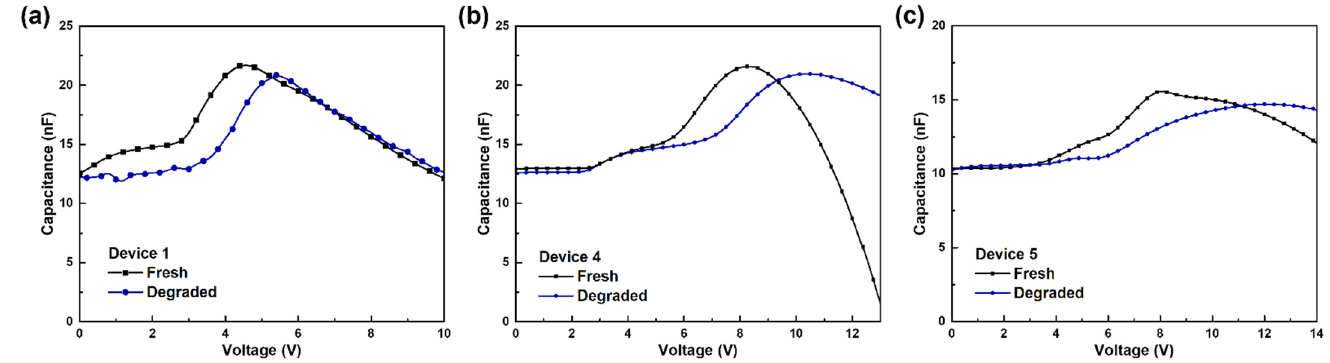
Figure 5. C-V characteristics of blue TADF OLEDs before and after degradation: ( a ) Device 1, ( b ) Device 4, and ( c ) Device 5. Table 6. Peak voltage and peak capacitance shift values after degradation of devices 1, 4, and 5.